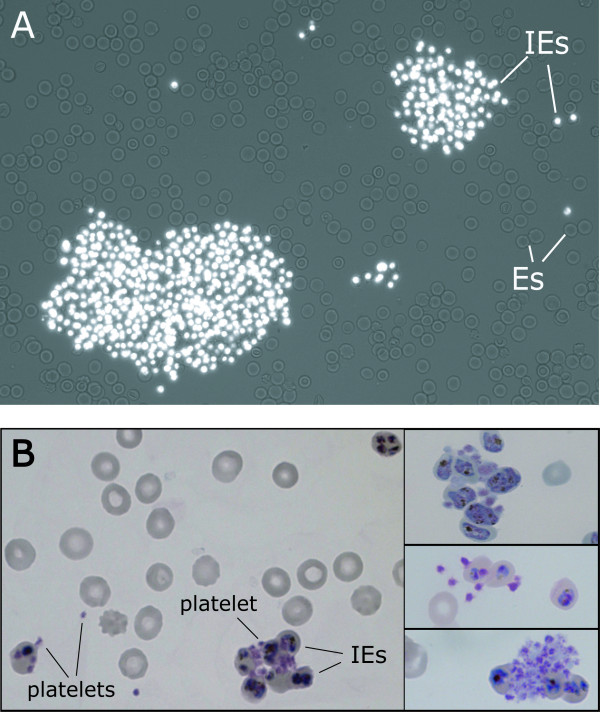
Platelet-mediated clumps of P. falciparum infected erythrocytes (IE) detected by in vitro clumping assays. A. Platelet-mediated clumps of infected erythrocytes (IEs) from P. falciparum clone HB3 viewed by ethidium bromide staining and fluoresence microscopy (400×) of a wet preparation. Uninfected erythrocytes (Es) present in the clumping assay are unstained. B. Platelet-mediated clumps of HB3 IEs observed by Giemsa-stained thin smears and light microscopy (1000×).